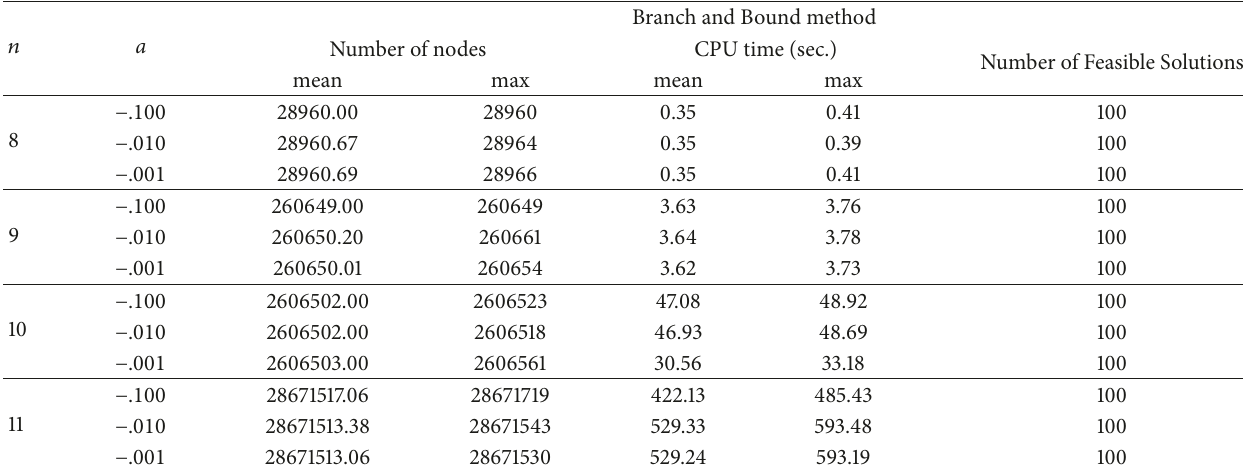
Table 1: Computational results of the branch-and-bound